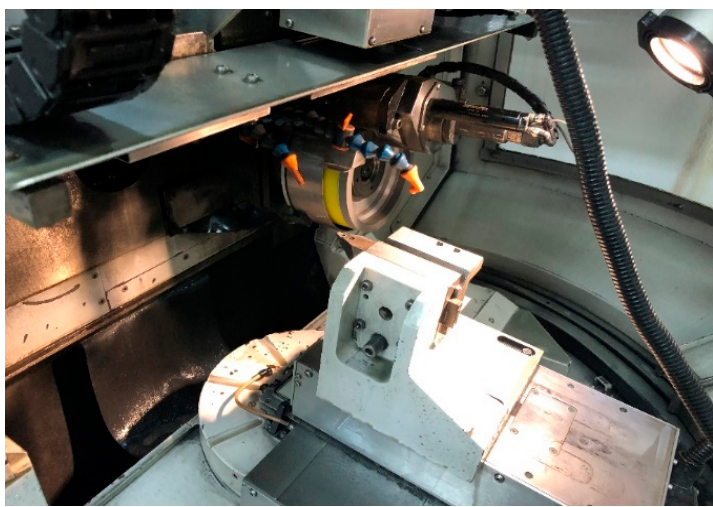
Figure 5. Sharpening of insert with PCD grinding in NC Coborn R9 (working zone).